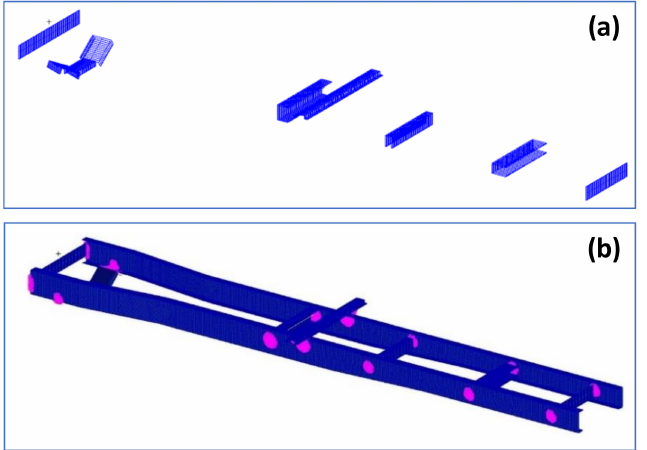
Figure 3. ( a ) Cross members and relative positions in the structure; ( b ) medium-fidelity finite element model of the baseline